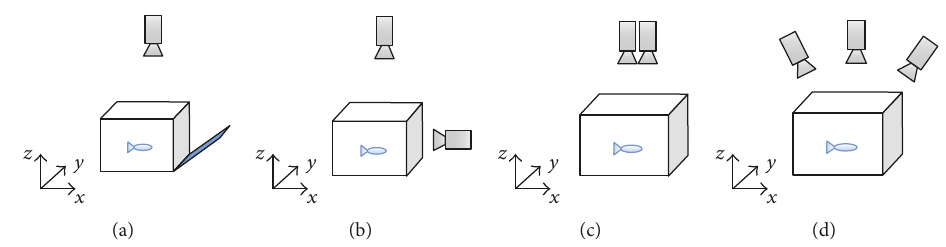
Figure 8: Structures of 3D observation systems.